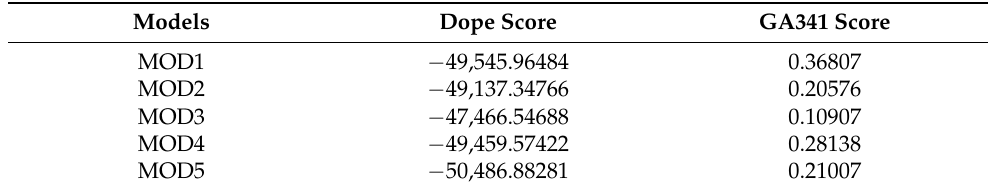
Table 2. Discrete optimized protein energy (DOPE) and GA341 scores of the 5 generated models using Modeller 9.2.